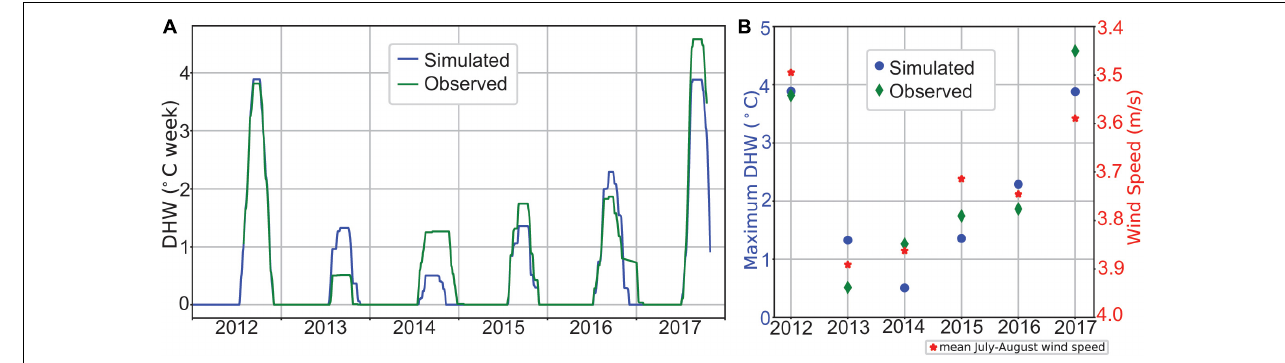
FIGURE 5 | (A) Degree heating weeks computed from the observed (green) and simulated (blue) sea-bottom temperatures at Saadiyat reef from 2012 to 2017. (B) Maximum DHW for each year (left axis) contrasted against average wind speed (July and August) (right axis; red star). Note that the right axis is inverted for ease of interpretation.